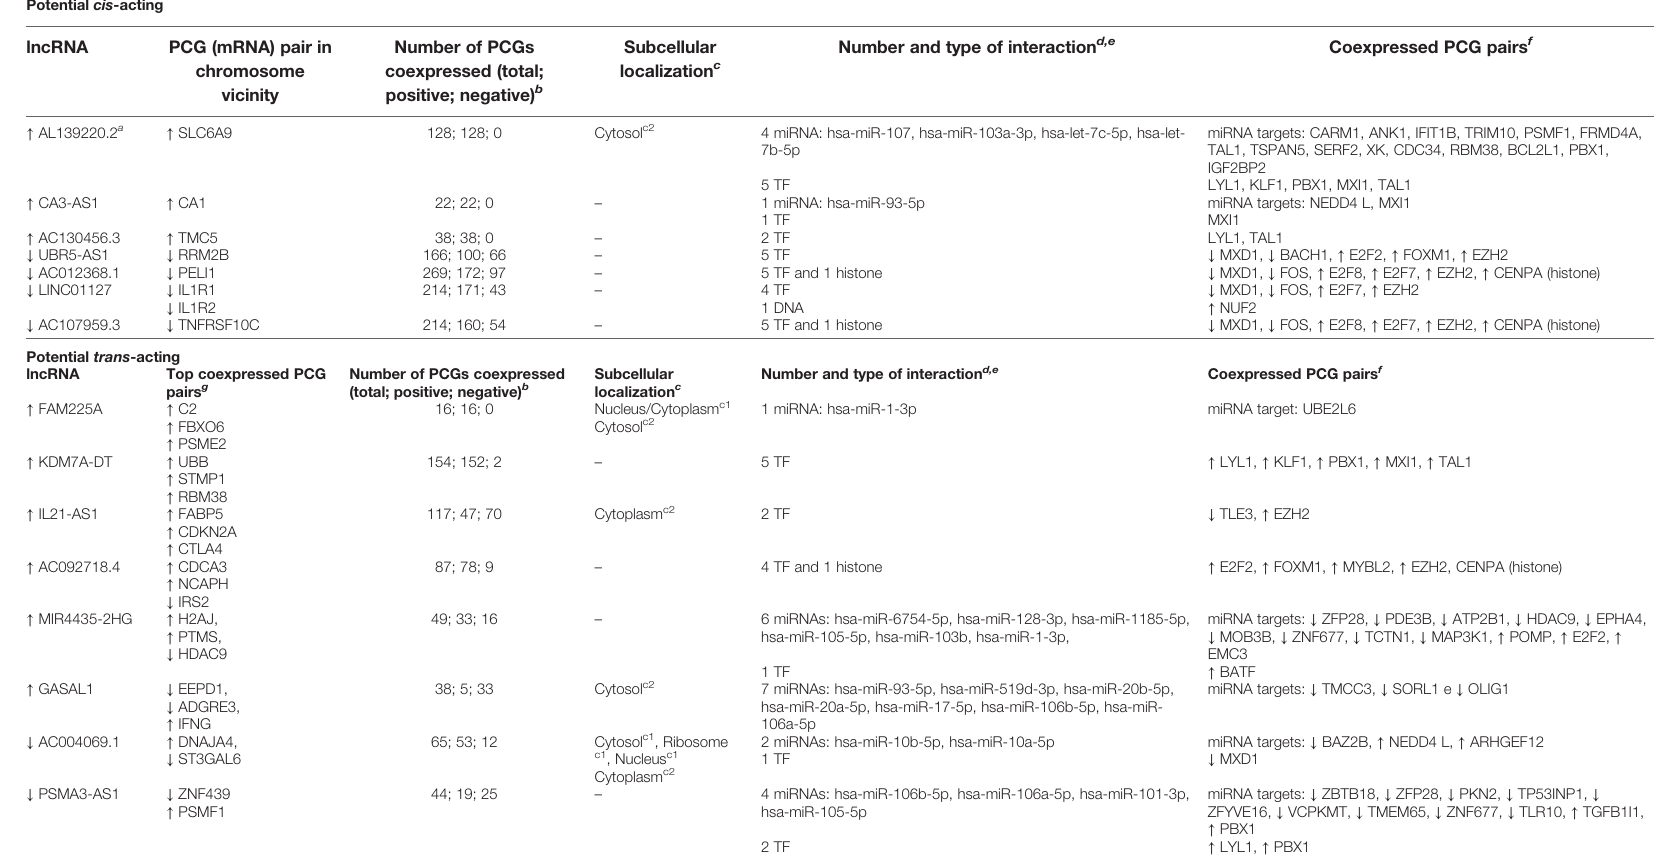
a lncRNAhub in network analysis( Figure 7 ). b Numbers were extracted from the expression correlation results available in Supplementary Table 4 . c Highlighted results from data mining in the LncSLdb Database (c1) or prediction by the LncLocator tool (c2). For in silico prediction, only scores higher than 0.7 (ranging from 0 to 1) were considered. d HighlightedresultsfromdatamininginRNAInterDatabase.InteractionsoflncRNAswithmicroRNAs(miRNAs),transcriptionfactors(TFs),RNAbindingproteins(RBPs),DNAandhistonemodi fi cations;whenlncRNAsexhibitedinteractionswithmiRNAs,targeted PCGs were listed. e All lncRNAs displayed here present at least 35 histone modi fi cation results. f PCGs were extracted from the expression correlation results available in Supplementary Table 4 . g PCGs with the highest correlation coef fi cients according to the results available in Supplementary Table 4 . Up or down arrows indicate the expression regulation pattern in VL patients (PD0